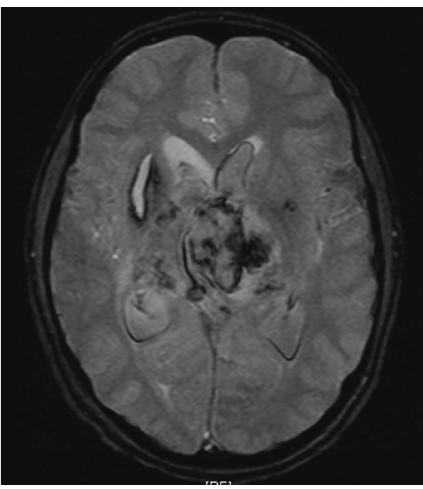
Figure 3: Axial GRE-heme sequence MRI 8 months after diagnosis, during presentation with status